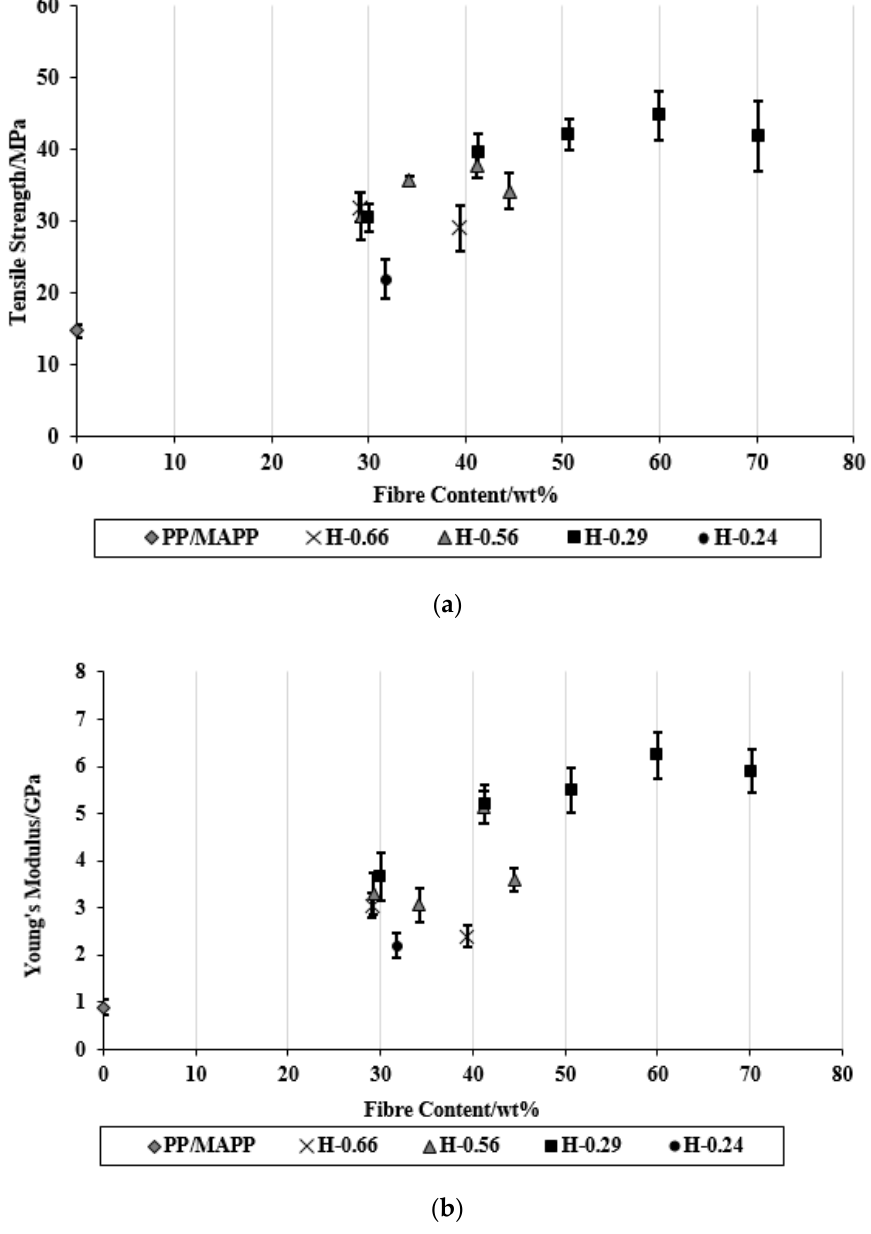
Figure 5. ( a ) Tensile strength and ( b ) Young’s modulus of composites as a function of fibre con- tent.